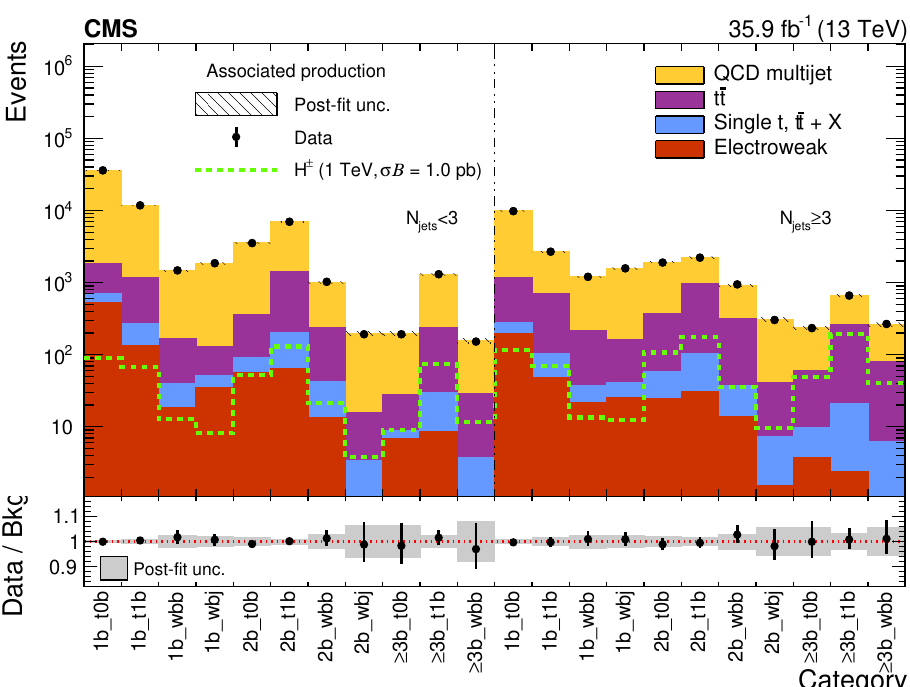
Figure 4 . Expected event yields for the boosted analysis in the mass window as de(cid:12)ned in (cid:12)gure 2 for an H (cid:6) with mass 1 TeV in each of the signal categories used in the associated production model. < 3), while categories on the right The 11 categories on the left have low jet multiplicity ( N jets (cid:21) 3). The yields observed in data (black markers) are overlaid. have high jet multiplicity ( N jets The dashed lines represent the yields for an H (cid:6) with a mass of 1 TeV and (cid:27) B = 1 pb for associated production. The background distributions result from the global (cid:12)t described in the text for the background-only hypothesis. Similar categories are (cid:12)tted for the s -channel production.